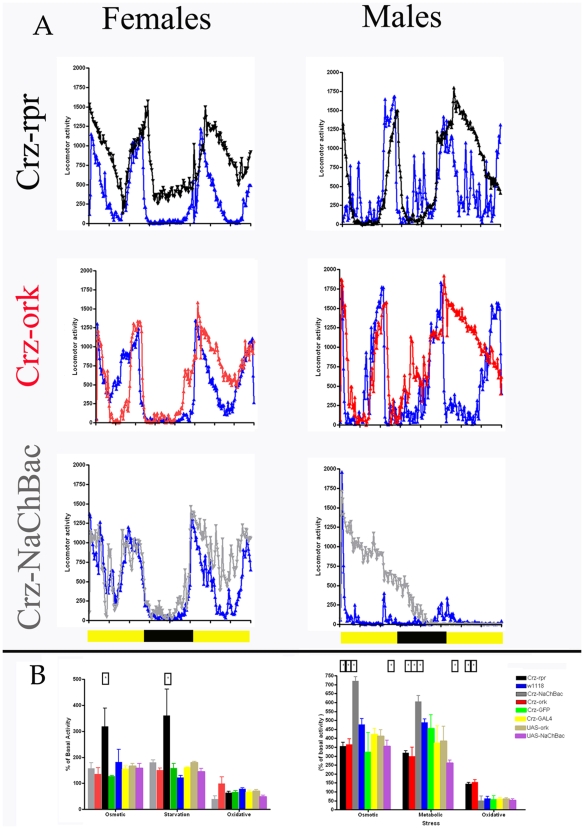
The amount of stress-induced activity differs in males and females with similar corazonin neuronal manipulations.
A. Representative locomotor activity profiles from different populations under normal (blue) and starvation conditions (black–crz-rpr; red- crz-ork; gray–crz-NaChBac) from females (left panels) and males (right). B. Quantification of the percent of basal locomotion associated with starvation, osmotic, and oxidative stress from three replicate runs per condition (means +/− SEM). Asterisks indicate statistically significant differences from w1118.